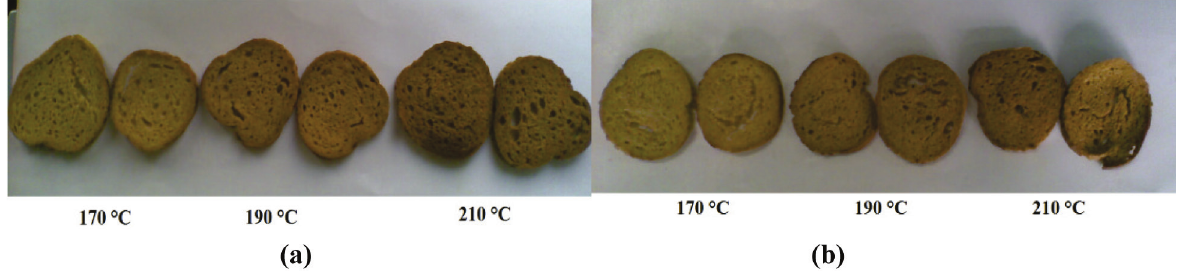
Figure 2 - Images of T-10CMP ( a ), and T-10CM ( b ) snacks.